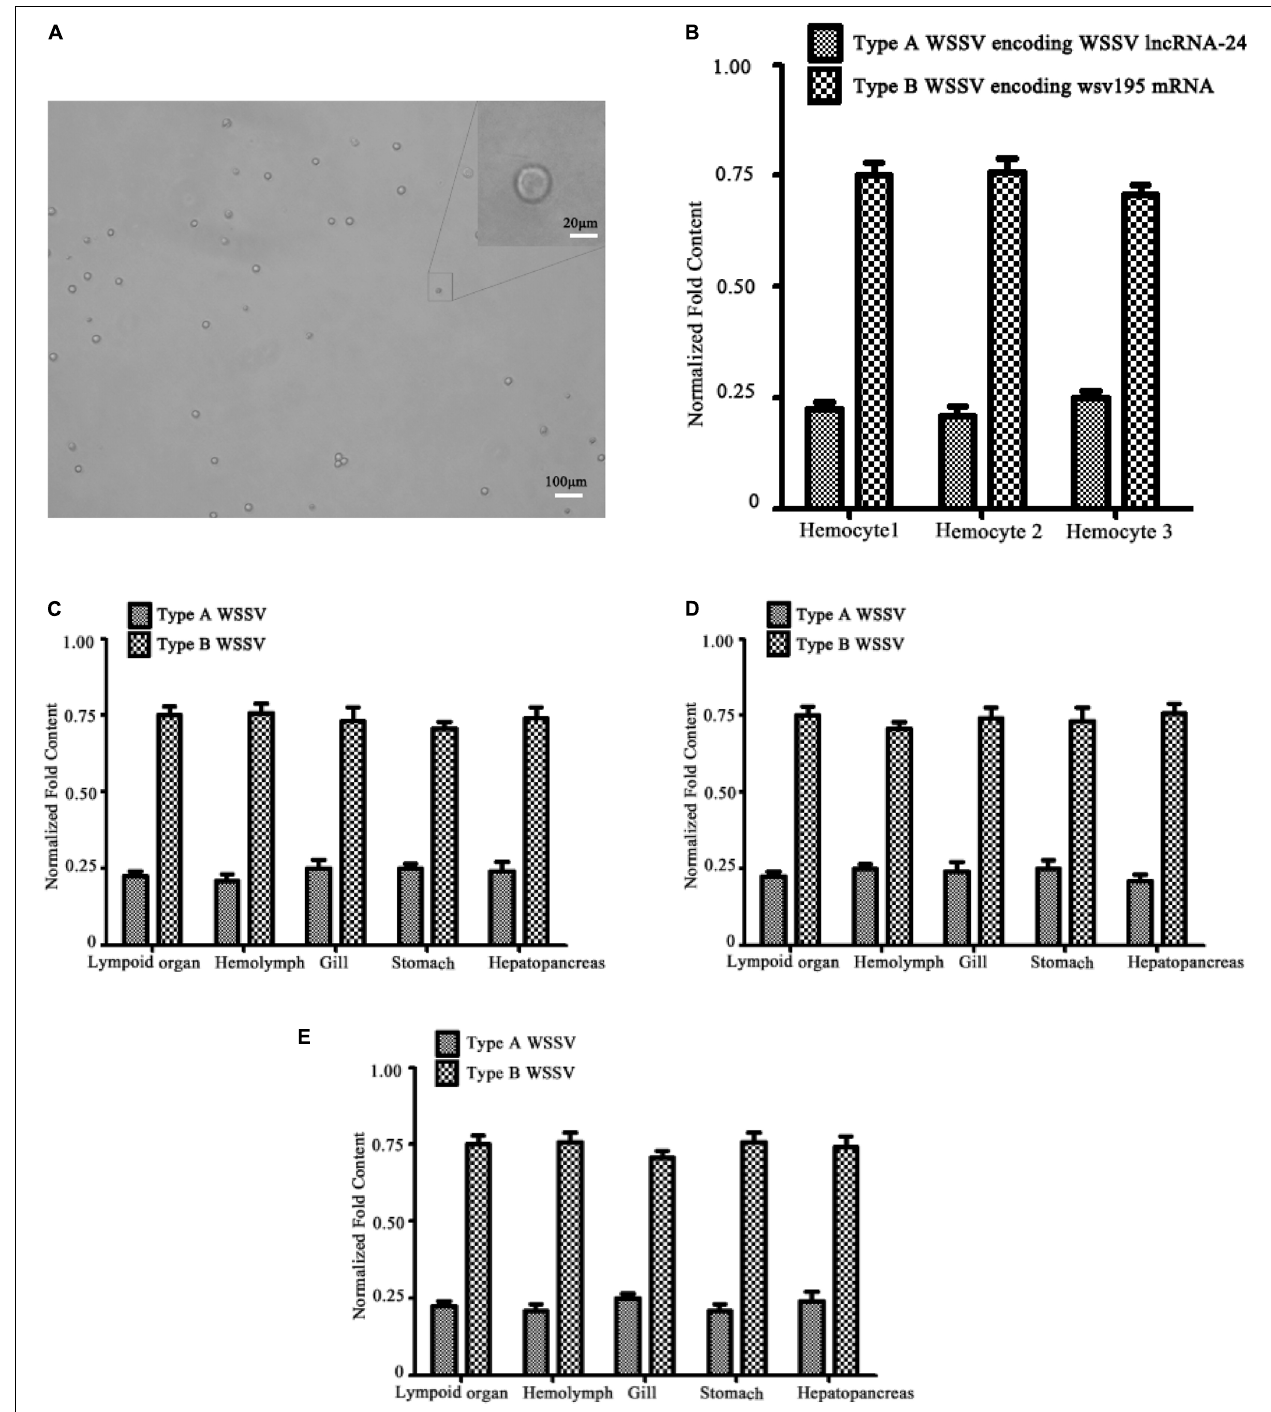
FIGURE 2 | Existence of virus populations in situations ranging from single virus-infected cells to different virus-infected hosts. (A) Isolation of single haemocytes from the haemolymph of WSSV-infected shrimp. (B) Existence of two types of WSSV genomes in single shrimp haemocytes. Single haemocytes from the haemolymph of WSSV-infected shrimp were subjected to quantitative real-time PCR to detect Type A WSSV and Type B WSSV. (C) Identification of viral genome heterogeneity in different tissues or organs of WSSV-infected shrimp. Shrimp were infected with WSSV. At 48 h post infection, the WSSV genome in different tissues or organs of shrimp was detected with quantitative real-time PCR. (D) Viral genome heterogeneity in different tissues or organs of WSSV-infected crayfish. (E) Distribution of two types of WSSV genomes in different tissues or organs of WSSV-infected mud crabs. All the experiments are biologically repeated for three times.